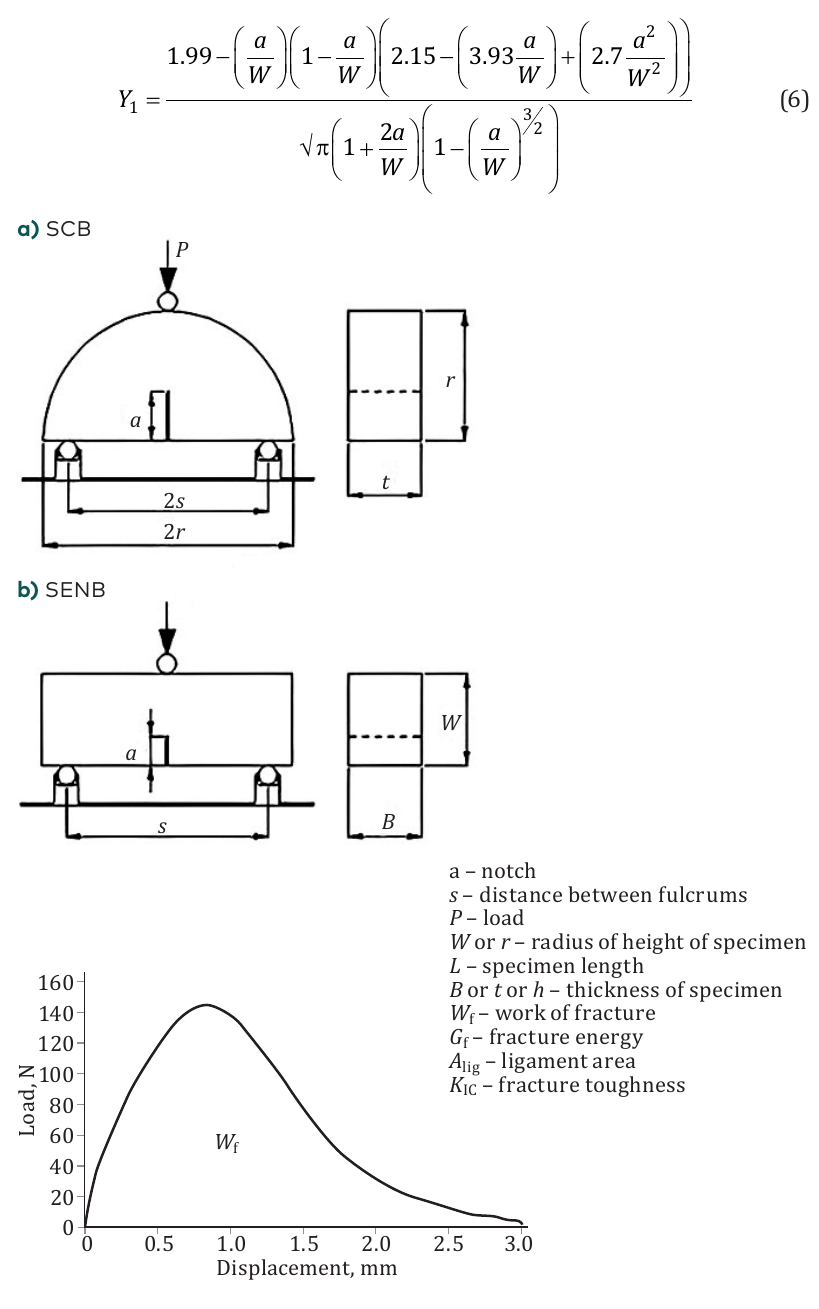
Figure 5. Test setup and typical Load-Displacement curve (a) SCB (b)